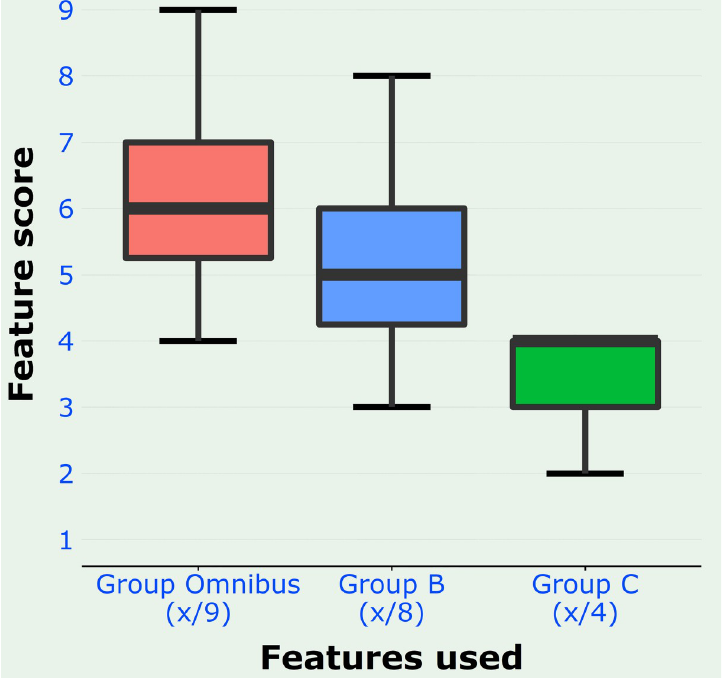
Fig 4. Boxplot of distribution of scores based on 3 groups of features: all features (Group Omnibus), those with association to disease by Chi-squared test (Group B) and those with high strength of association by Crame´r’s V coefficient (Group C). The tips of the whiskers in these boxplots represent the minimum and maximum scores of the various groups.